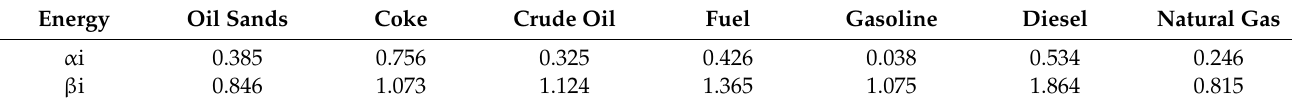
Table 3. Energy standard coal coefficient α i and carbon dioxide emission coefficient β i .